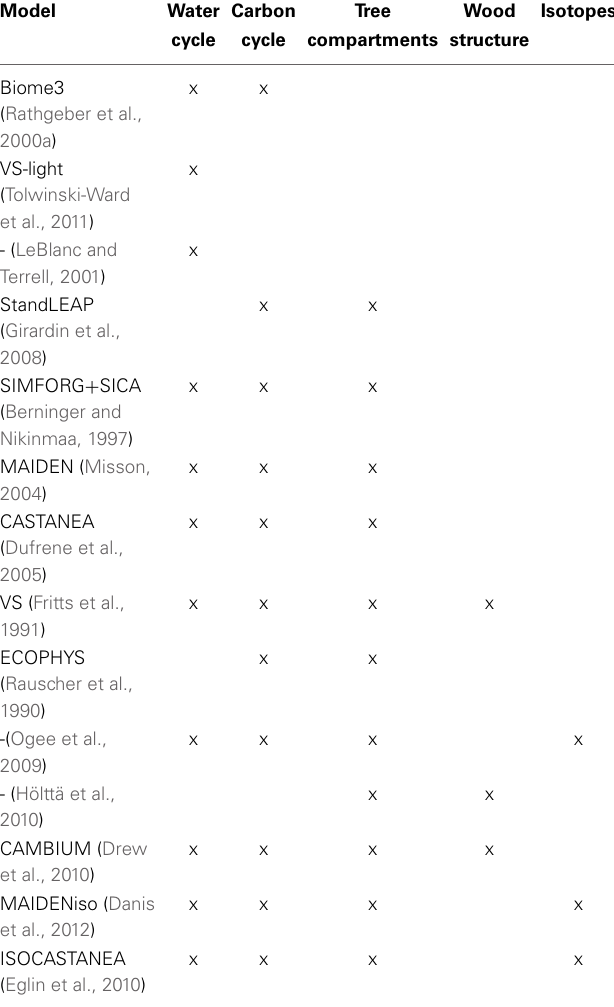
Table 1 | Rough classification of the models cited according to the main processes